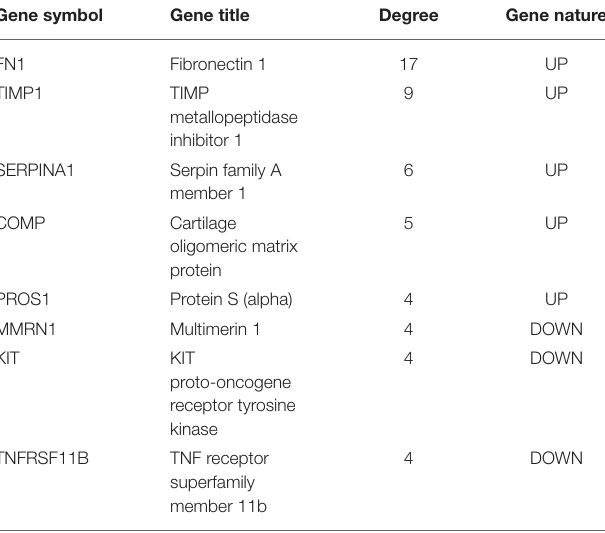
TABLE 2 | Hub genes with higher degree of